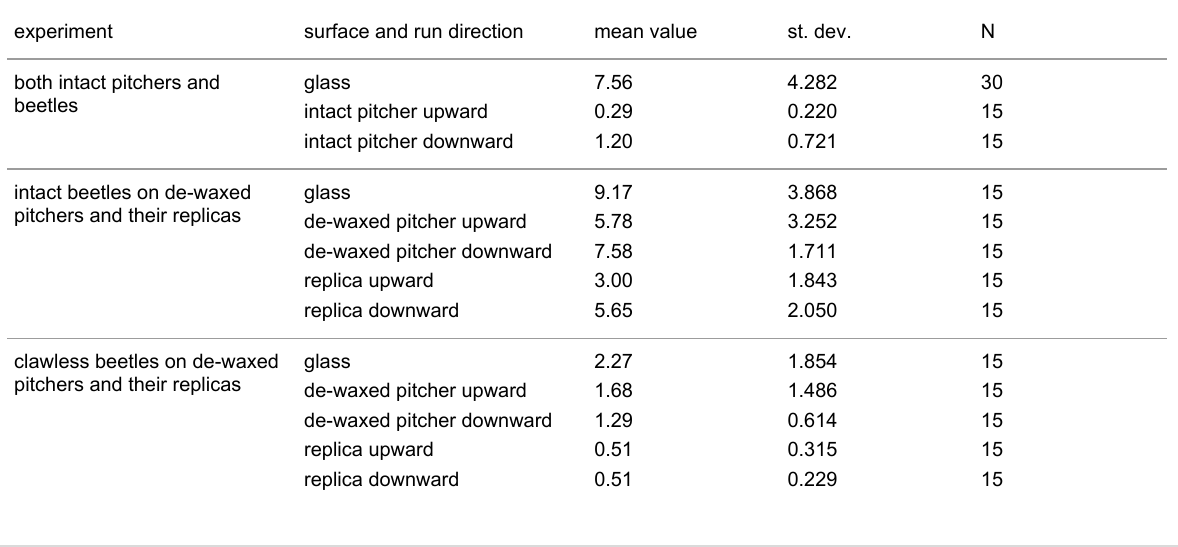
Table 1: Traction forces (in mN) generated by Coccinella septempunctata beetles.